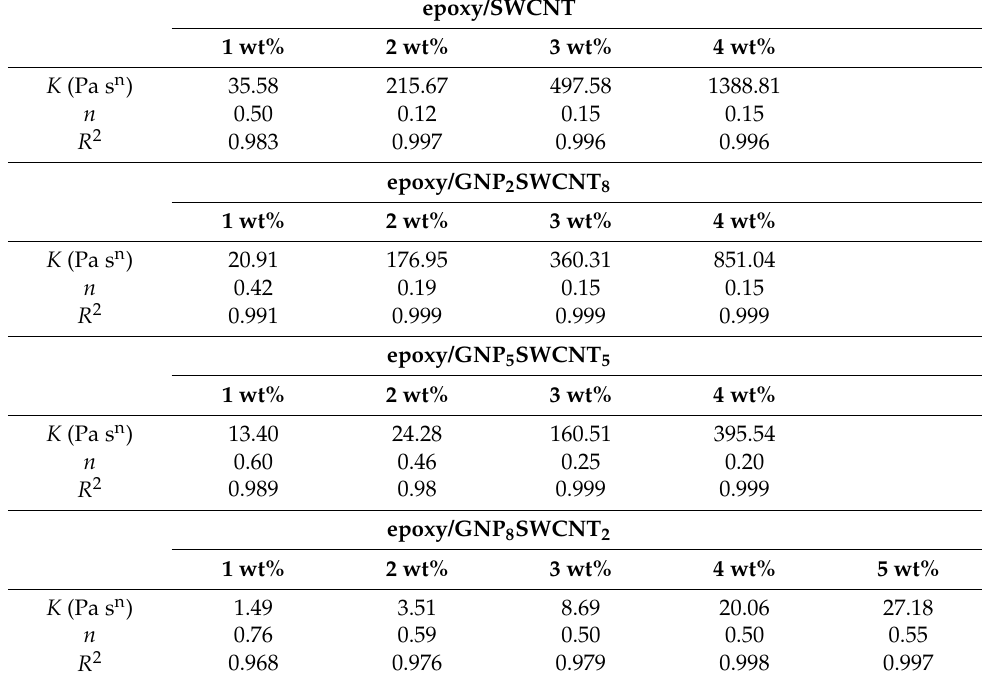
Table 1. Rheology parameters of RTM6 epoxy resin with different loadings of SWCNTs and GNPs determined from non-linear least-squares fit of viscosity data (measured at 80 ◦ C) using the power law